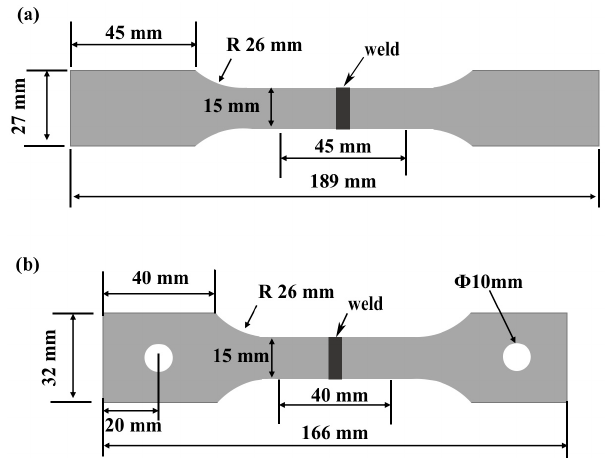
Figure 1. Dimensions of the specimens in tensile testing: ( a ) sample design for room temperature testing; ( b ) sample design for high temperature testing.